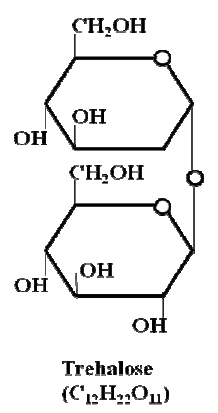
FIGURE 1. Molecular structure of